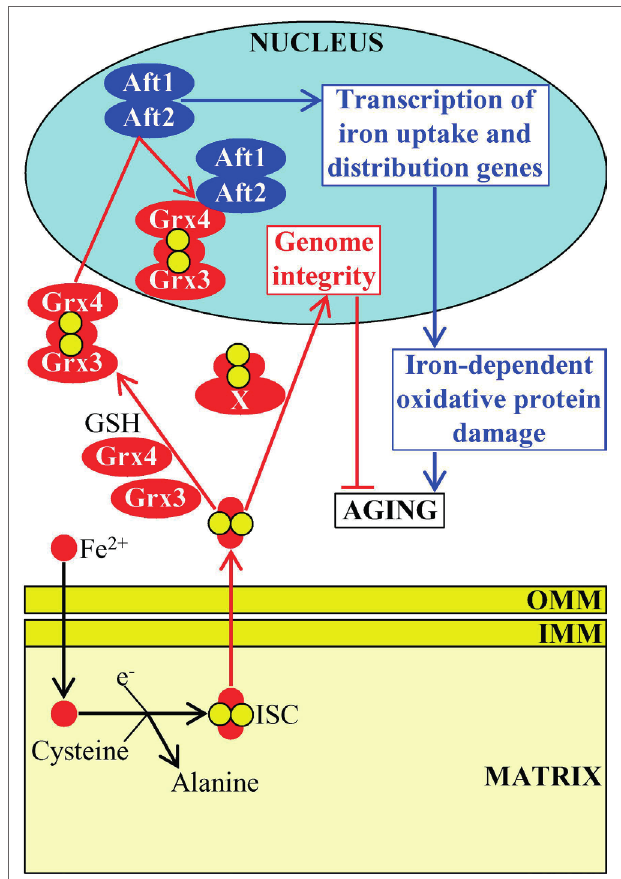
FIGURE 6 | Mitochondria-generated iron-sulfur clusters (ISC) influence the aging process. Following their synthesis and assembly in mitochondria, ISC are exported to the cytosol where they bind to the monothiol glutaredoxins Grx3 and Grx4. This promotes the formation of Grx3/Grx4 dimers, stimulates nuclear import of Grx3/Grx4, suppresses transcription of genes involved in iron uptake and intracellular distribution, weakens the iron-dependent oxidative damage to proteins, and ultimately delays cellular aging. Some other ISC-containing proteins are also imported from the cytosol into the nucleus, where they support the maintenance of nuclear genome integrity. Activation arrows and inhibition bars denote pro-aging (displayed in blue color) or anti-aging processes (displayed in red color). Pro-aging or anti-aging proteins are displayed in blue or red color, respectively. See the text for additional details. Abbreviations: Aft1, activator of ferrous transport 1; Aft2, activator of ferrous transport 2; IMM, inner mitochondrial membrane; OMM, outer mitochondrial